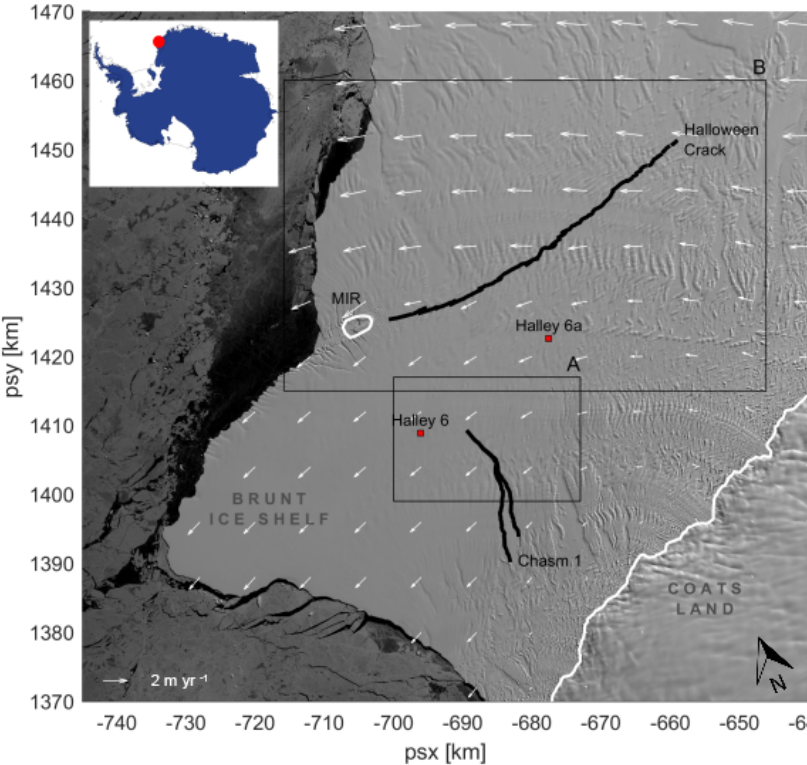
Figure 1. The Brunt Ice Shelf covers a 6500km 2 area along the Coats Land coastline in East Antarctica (see inset). The grounding line from the SCAR Antarctic Digital Database 6.0 (ADD; www.add.scar.org) is delineated in white and marks the boundary between the ice shelf and the adjacent continent, as well as a small pinning point at the McDonald Ice Rumples (MIR), which is absent in the ADD. The background image is a subset of a Landsat 8 scene (panchromatic band) from 15 March 2017, which was used to outline the present-day active rifts, Chasm 1 and Halloween Crack, which are highlighted in black. The flow of the ice shelf is illustrated by white arrows, sampled on a regular 8km by 8km grid. Red dots indicate the location of the Halley 6 Research Station (operational since 2012) and its new location at Halley 6a (since February 2017). The black boxes indicate the geographical extent of Figs. 2a (A) and 3